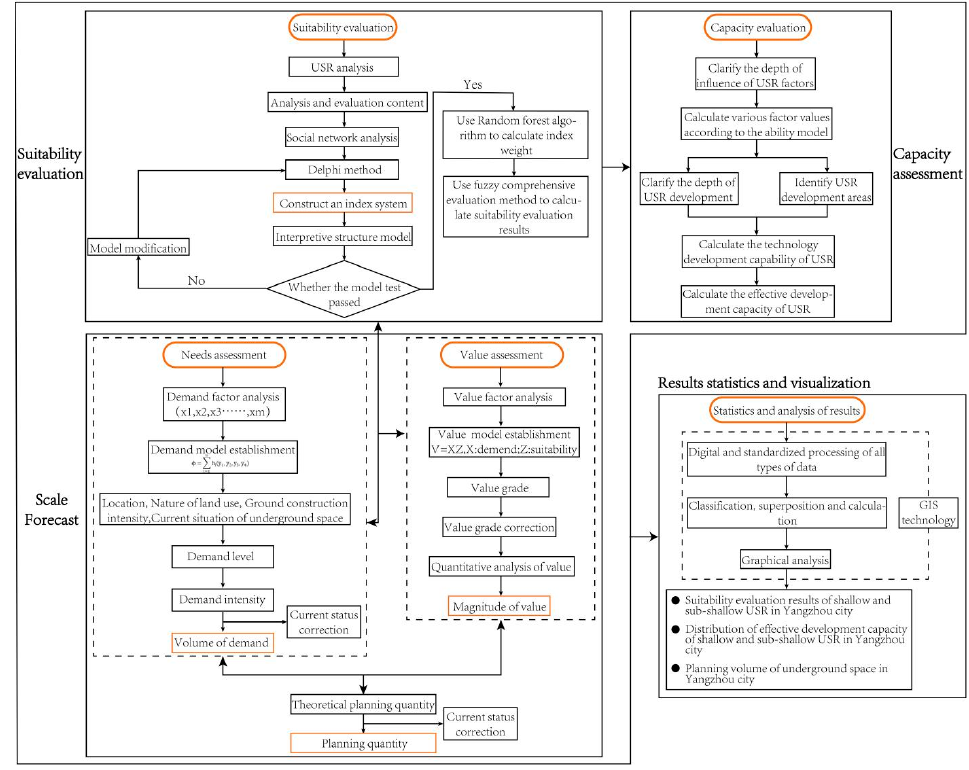
Figure 3. The framework of multi-layer information superposition method.